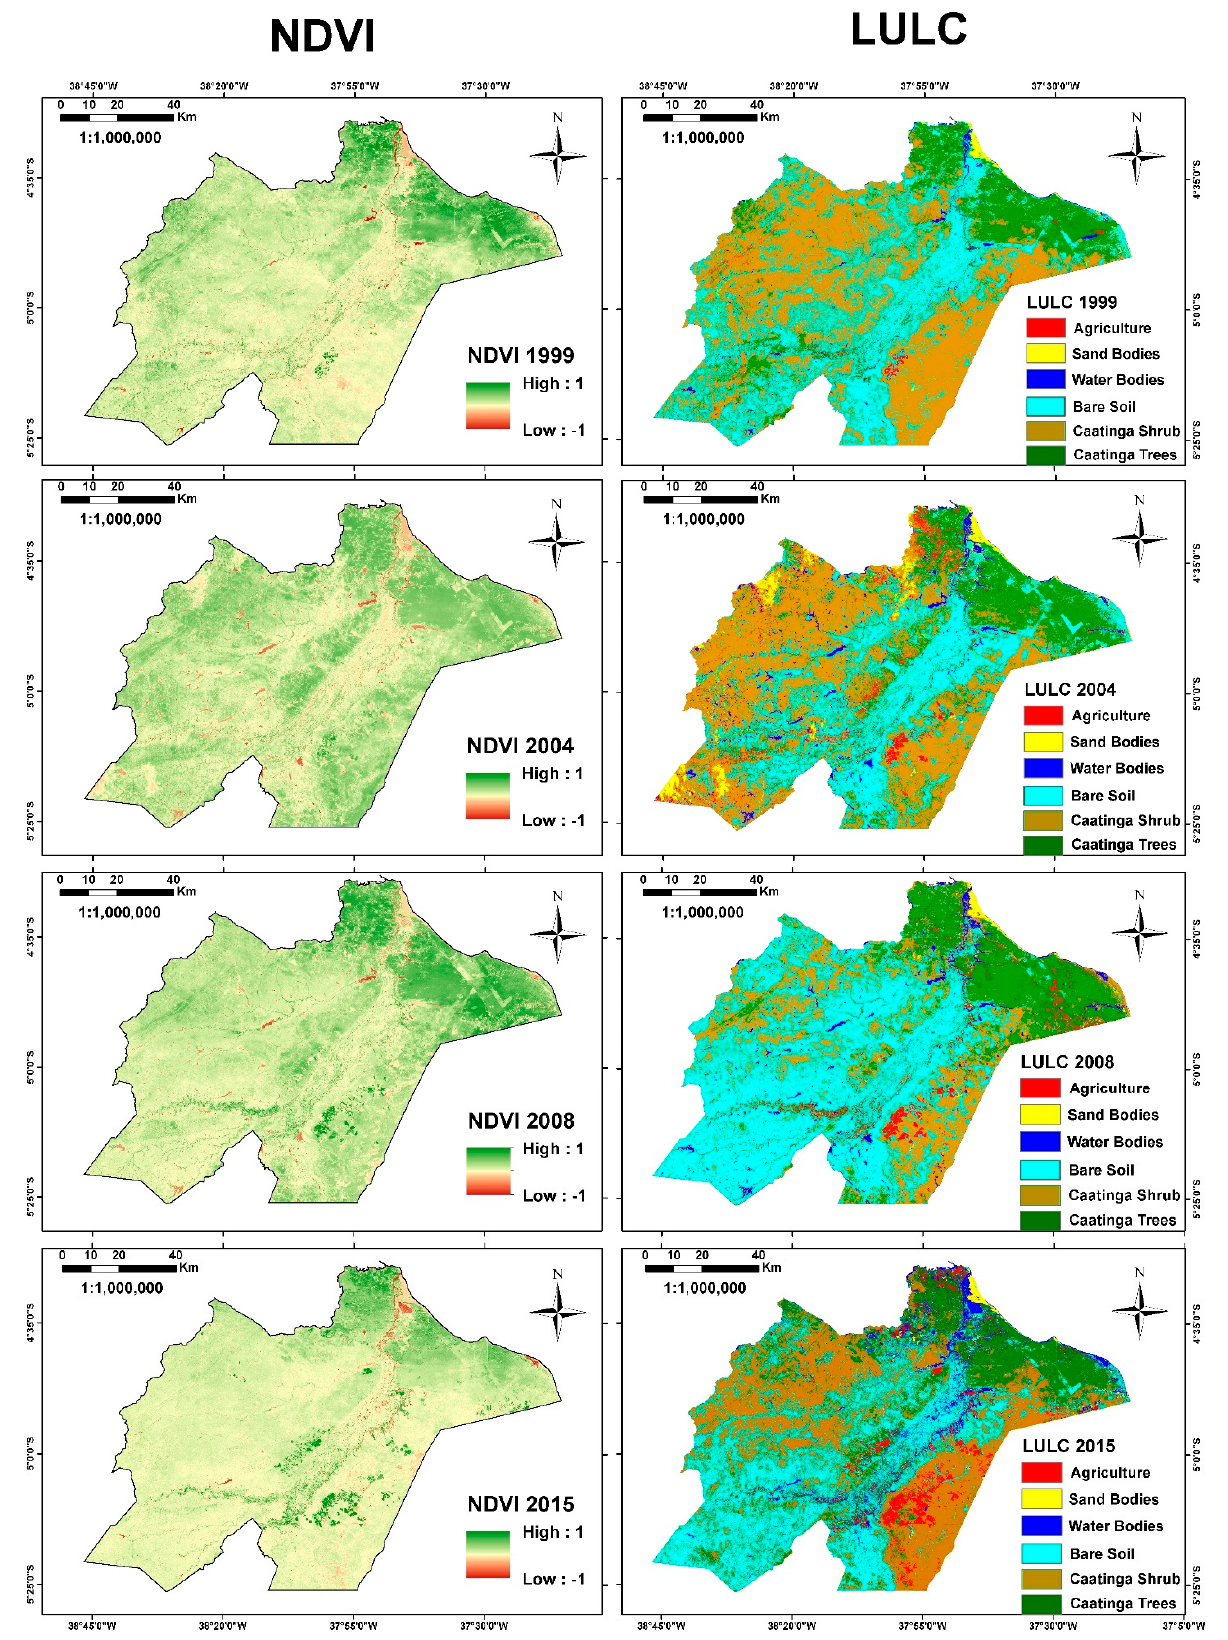
Figure 3. Land use and land cover and NDVI in the LJRSB for 1999, 2004, 2008, and 2015.